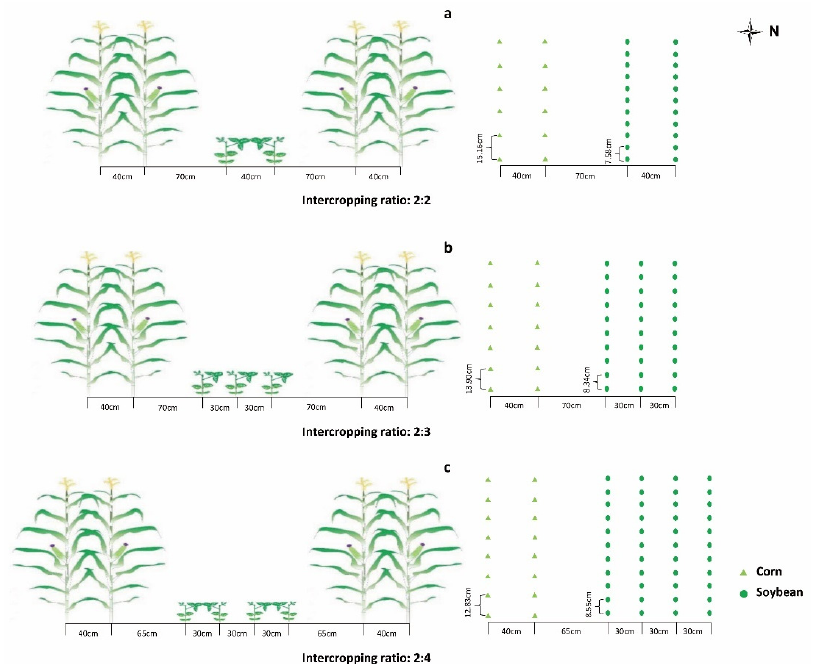
Figure 1. The soybean and the corn space arrangements. ( a – c ) represent the layout of intercropping ratio was 2:2 (60,000 plants ha − 1 for corn, 120,000 plants ha − 1 for soybean), intercropping ratio was 2:3 (60,000 plants ha − 1 for corn, 150,000 plants ha − 1 for soybean), and intercropping ratio was 2:4 (60,000 plants ha − 1 for corn, 180,000 plants ha − 1 for soybean), respectively. Silage treatment was conducted corresponding to the three different plots in the field with the same sampling method with yield determination in 2020. A total of 27 bags were used (3 planting densities × 3 sowing times × 3 replicates). The corn and the soybean were